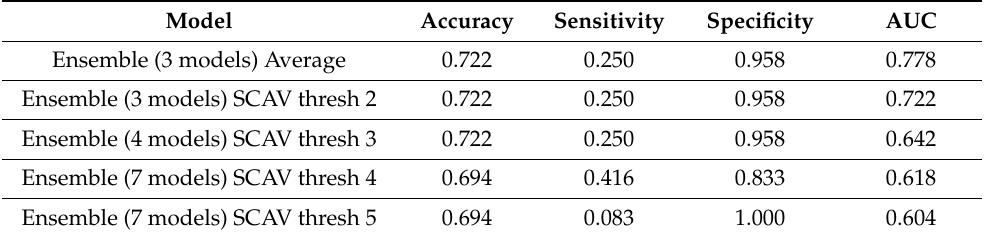
Table 10. KRAS mutation best results on Test dataset, ensembles of